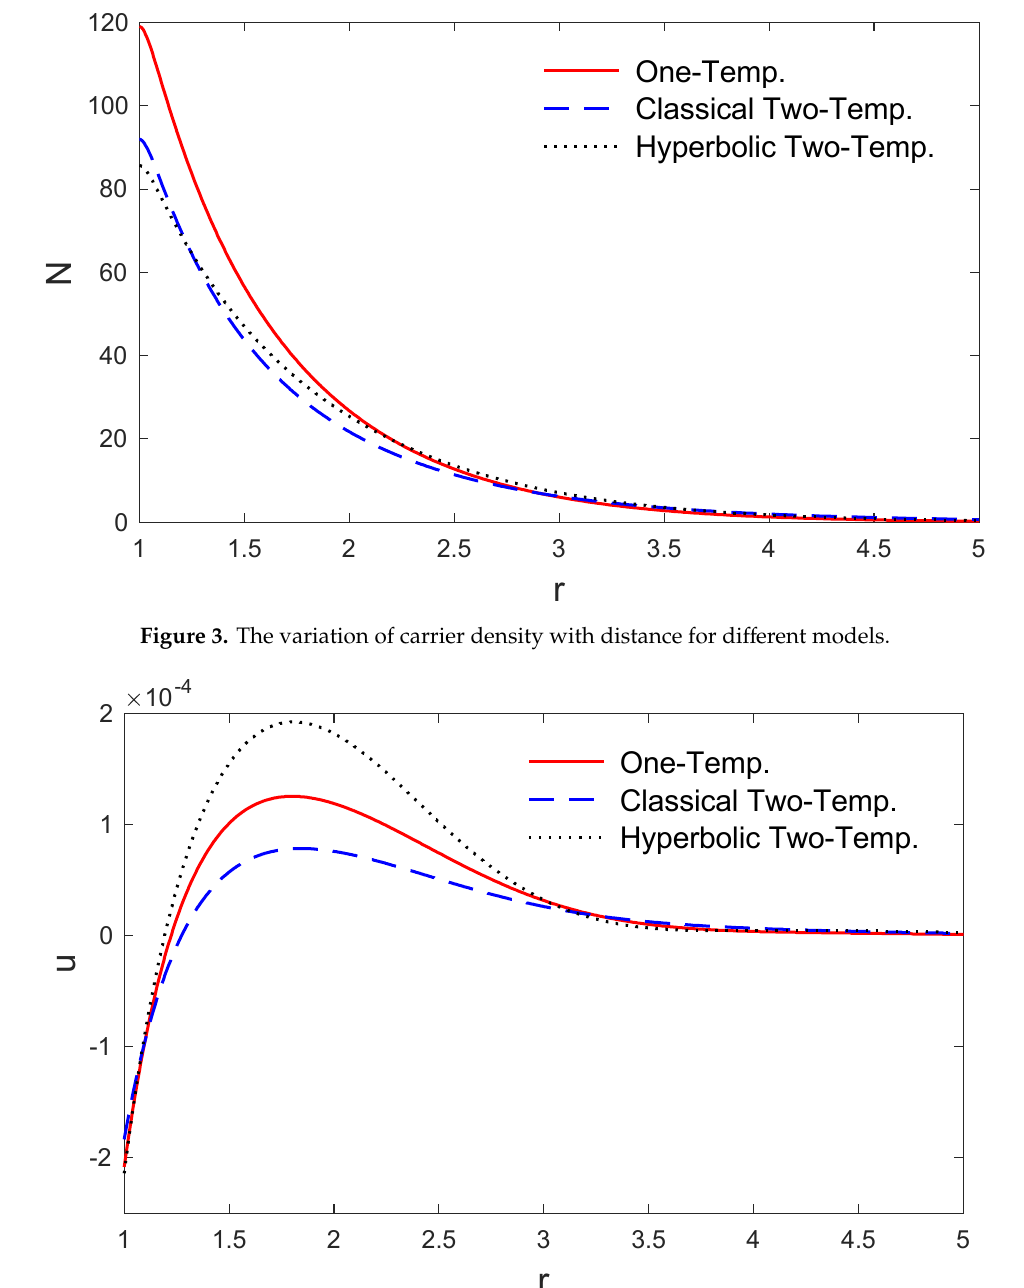
Figure 2. The variation of thermodynamic temperature with distance for different models.